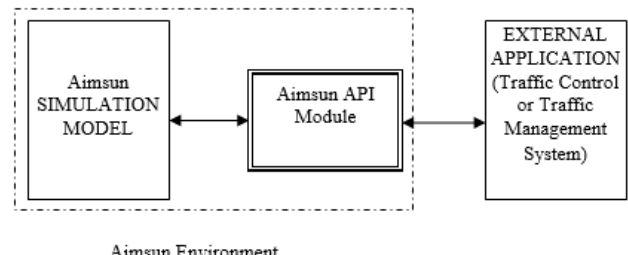
Figure 9. Aimsun Next API Implementation [7].